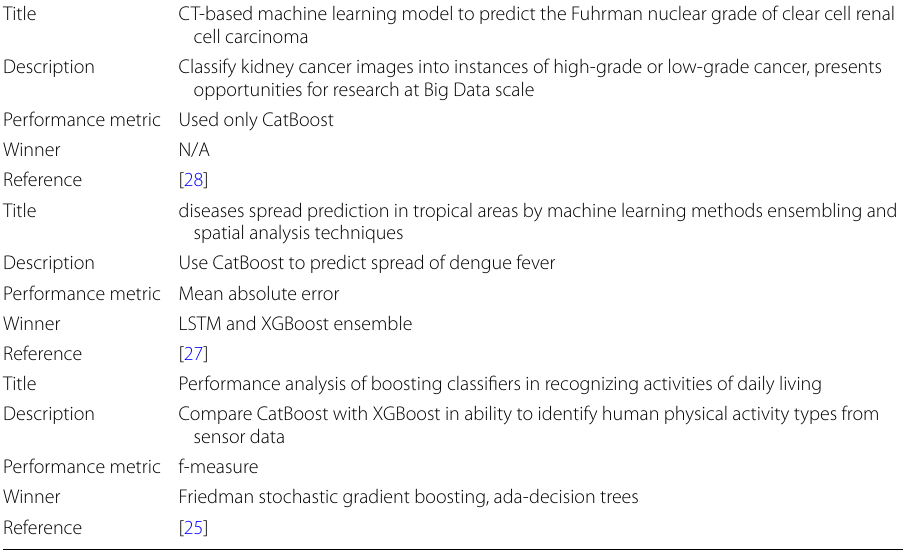
Predicting online shopping behavior from clickstream data using deep learning Description CatBoost is part of ensemble that is best clickstream predictor Performance metric